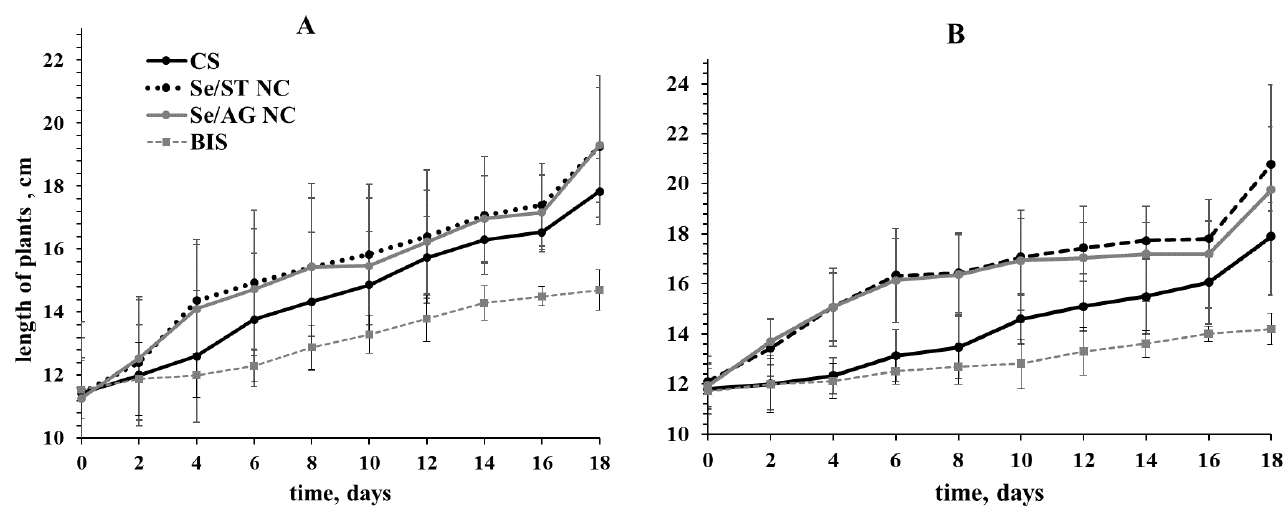
Figure 4. Effect of treatments by Se/AG and Se/ST NCs on the growth of Lukyanovsky ( A ) and Lugovskoy ( B ) potato varieties in vitro; CS—control samples.